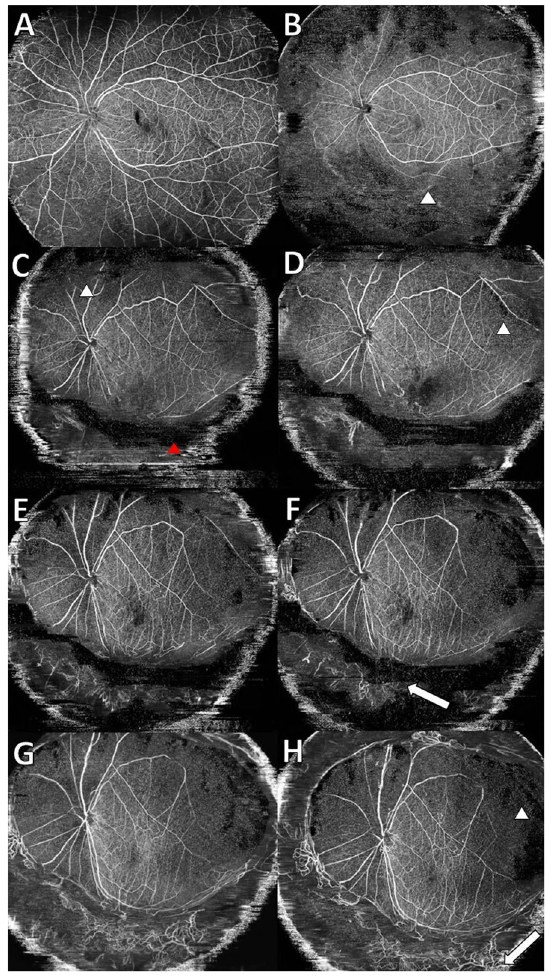
Fig. 3 En-face ultra-widefield optical coherence tomography angiography (OCTA) images of the left eye for Case 2 ( A - H ). A The first visit, B 1 month after surgery, C 2 months later, D 3 months later, E 6 months later, F 10 months later, G 1 year later, H After 1 year and 4 months (red arrow head: posterior vitreous detachment line, white arrow: anastomosis) Over the course of 1 year, There is peripheral neovascularization with straightening of the vessels towards inferiorly, there seems to be traction on the macula also. The images have several